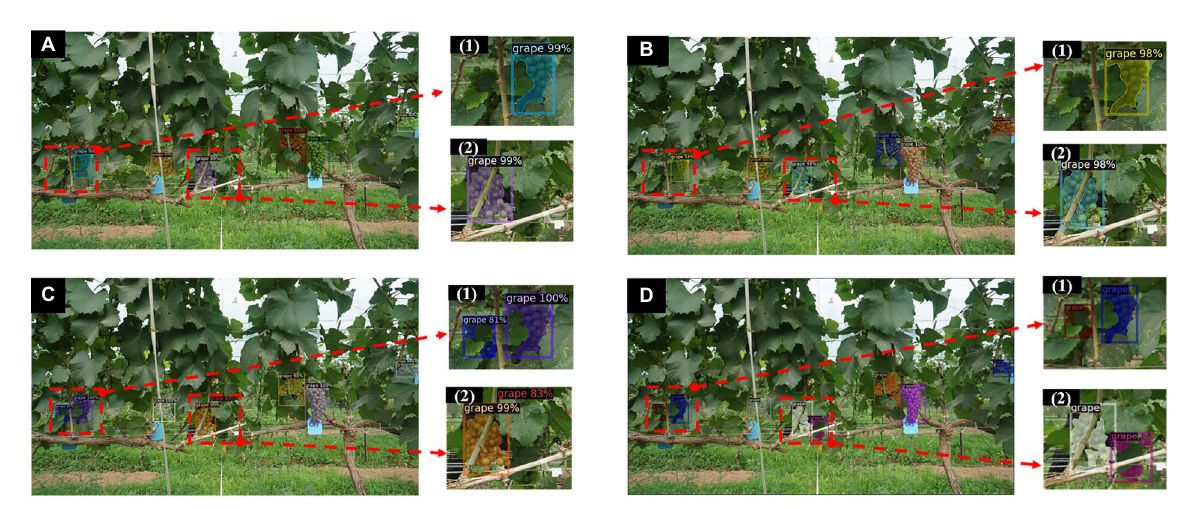
FIGURE 8 Instance segmentation results by Mask R-CNN with different backbones. (A) Instances segmentation results of Mask RCNN with ResNet50-FPN. (B) Instances segmentation results of Mask RCNN with ResNet101-FPN. (C) Instances segmentation results of improved Mask RCNN with ResNet50- FPN-ED. (D) Ground truth results. (1, 2) are partial enlargements of the instance segmentation results of the corresponding images,